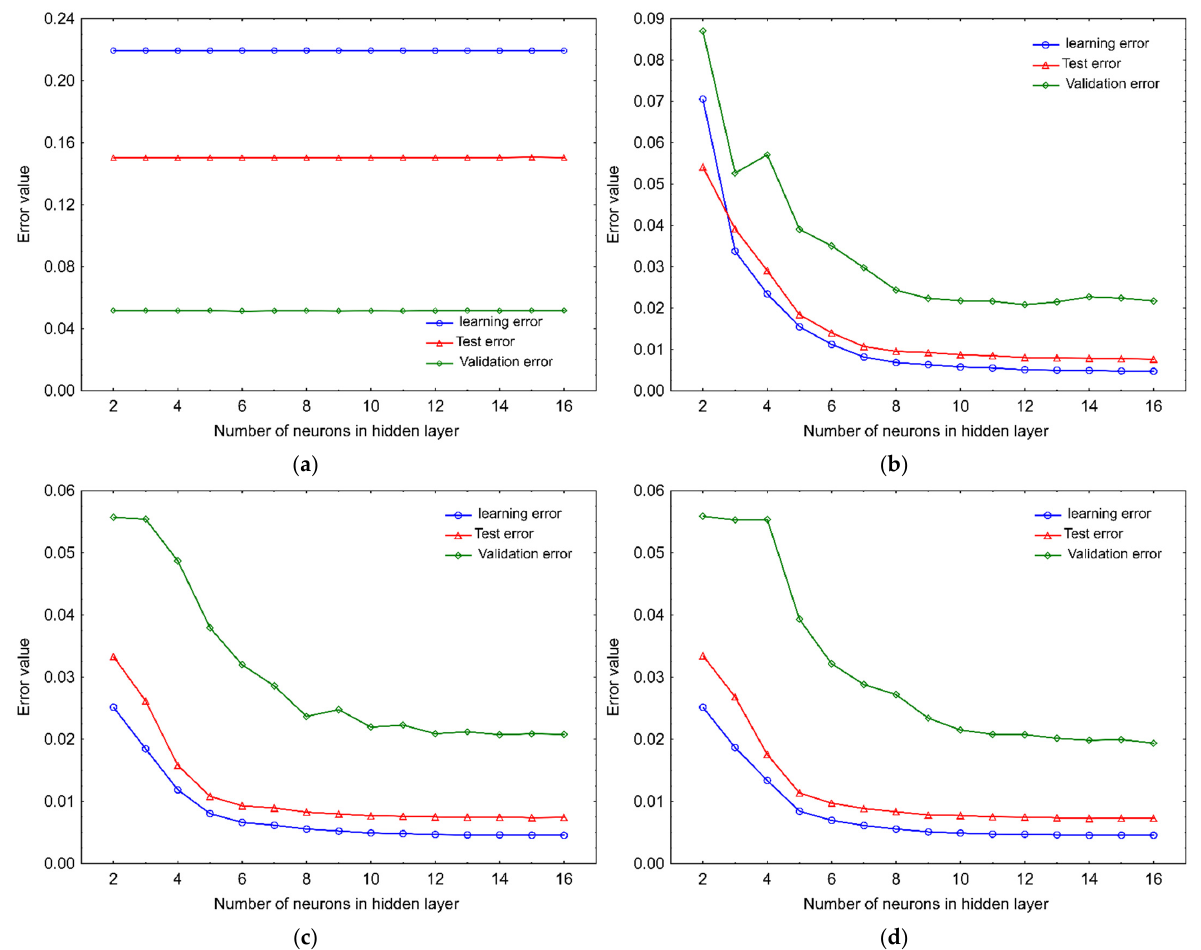
Figure 1. Changes in mean values of training, test and validation errors of MLP networks applied to modeling of phytosterol degradation depending on the number of neurons in the hidden layer equipped with an activation function in form of ( a ) a linear, ( b ) an exponential, ( c ) a hyperbolic tangent and ( d ) a logistic function.